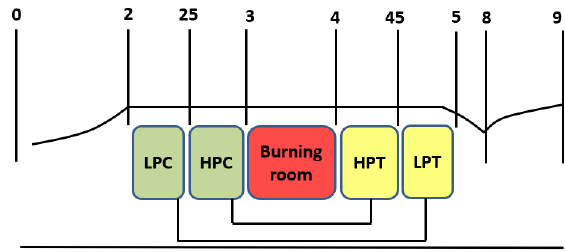
Figure 2. Principal components of two-spool turbo jet.